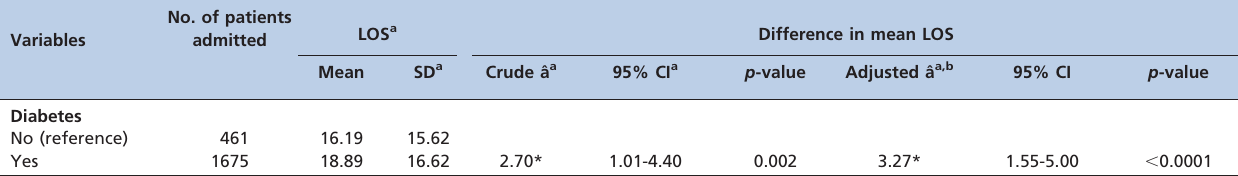
a LOS=length of hospital stay; SD=standard deviation; aˆ =regression coefficient,CI=confidence interval. b Estimated from multivariate linear regression model with adjustment for age, sex, treatment modality, geographic area, and urbanization level. * p , One population-based epidemiological study suggested